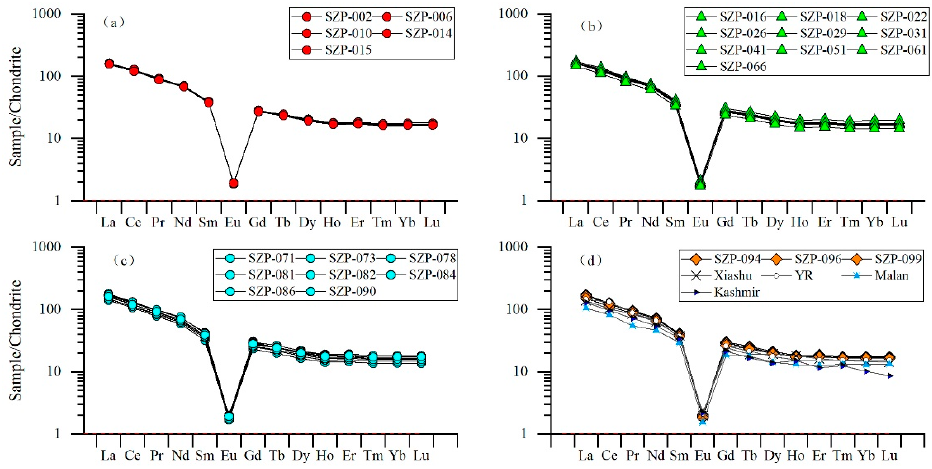
Figure 4. ( a – c ): representing the chondrite − normalized REE pattern of sediments from the SZP section in stages I, II, and III, respectively. ( d ): the chondrite − normalized REE pattern in stage IV with the comparison of that in the Xiashu loess (data from [67]), the Yangtze River fluvial sediments (YR), (data from [68]), northern Chinese Maran loess (data from [69]), and Indian wind − formed loess(data from [70]).